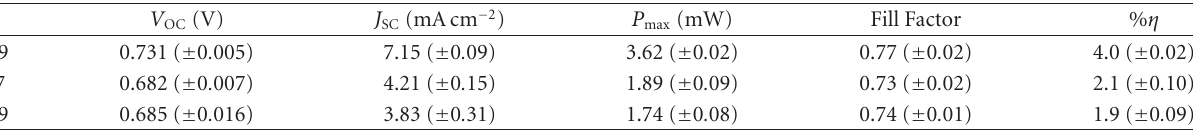
Table 1: Mean properties for cells made with the dyes shown.